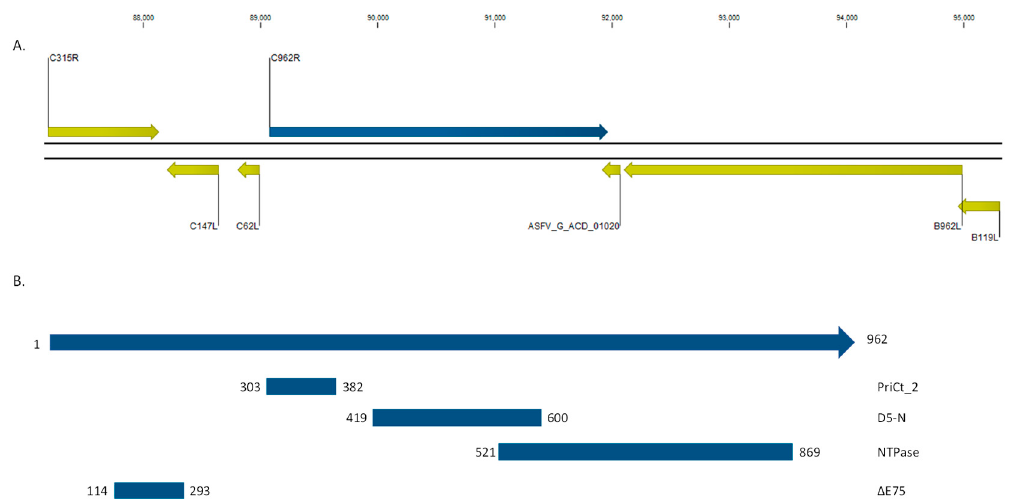
Figure 1. ( A ) Schematic representation of the C962R ORF (blue) in the ASFV-G genome, showing adjacent open reading frames (yellow). ( B ) Locations of the predicted functional domains in C962R, positions indicated are amino acid positions indicating the boundaries of the predicted domain. ∆ E75 represents the region that is deleted in the ASFV E75